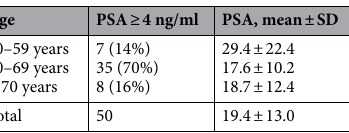
Table 4. PSA serum levels distribution according to age at diagnosis of PC. SD: standard deviation.